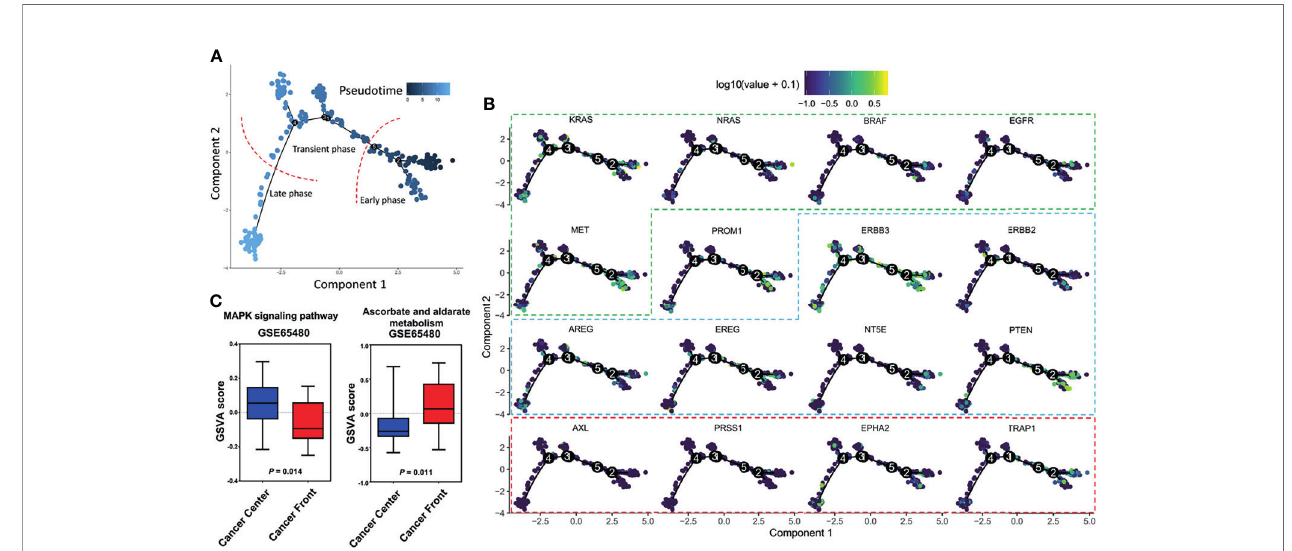
FIGURE 1 | Trajectory analysis of single-cell transcriptomes within colorectal cancers from GSE81861. (A) Cells following the development trajectory were classi fi ed as early, transient and late phases. (B) RNA expression of genes across the pseudotime trajectory. Genes from the EGFR signaling axis (KRAS, NRAS, BRAF, EGFR, and MET) are shown in the green frame. EGFR-sensitive genes (ERBB3, ERBB2, EREG, AREG, NT5E, and PTEN) are shown in the blue frame. EGFR-resistance genes (TRAP1, AXL, PRSS1, and EPHA2) are shown in the red frame. (C) Gene set variation analysis of bulk samples between the tumor front and the